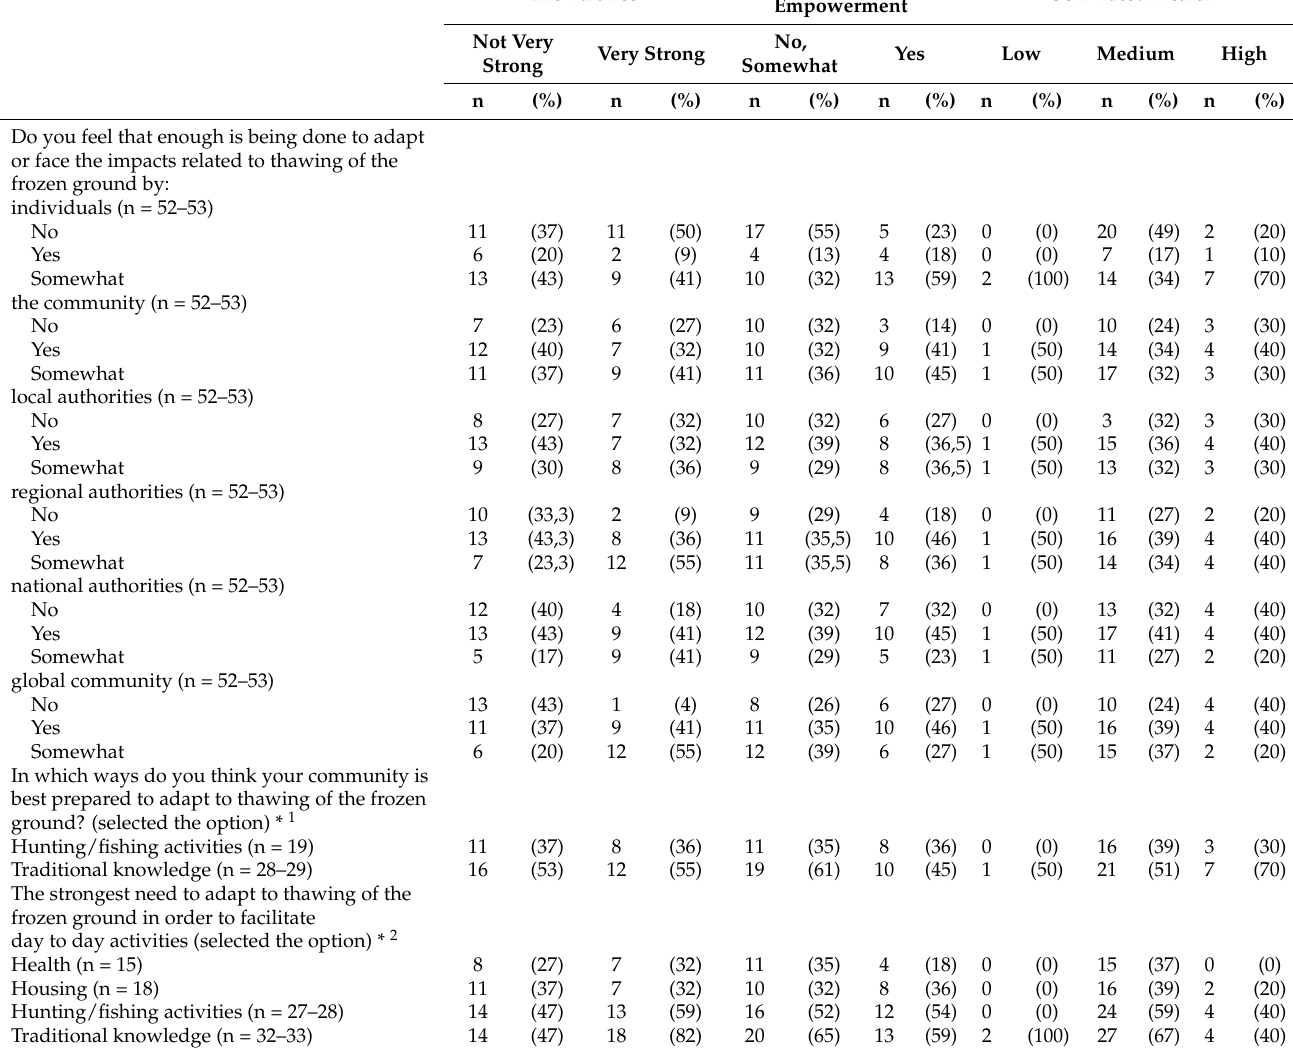
Table 4. Self-rated health, life balance and feeling of empowerment to face changes and perceived adaptation factors. Feeling of Life Balance Self-Rated Health Empowerment Not Very No, Very Strong Yes Low Medium Strong Somewhat